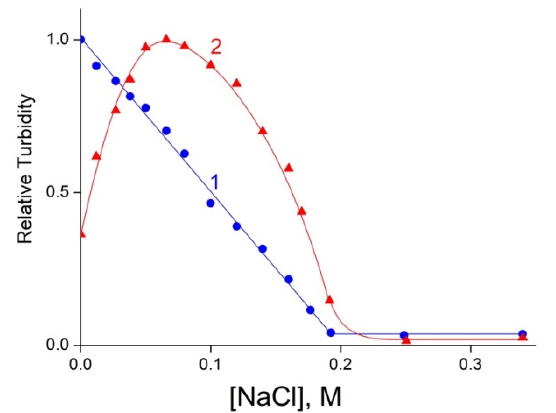
Figure 5. Relative turbidity of IPEC solutions at λ = 500 nm vs. NaCl concentration. ( 1 ) Water-soluble cationic IPEC with Q 1 = [ALG]/[QHECE] = 0.5, [QHECE] = 5 × 10 − 3 M and ( 2 ) water-soluble anionic IPEC with Q 2 = [QHECE]/[ALG] = 0.2, [ALG] = 5 × 10 − 3 М ; 10 − 2 М phosphate buffer of pH 7.